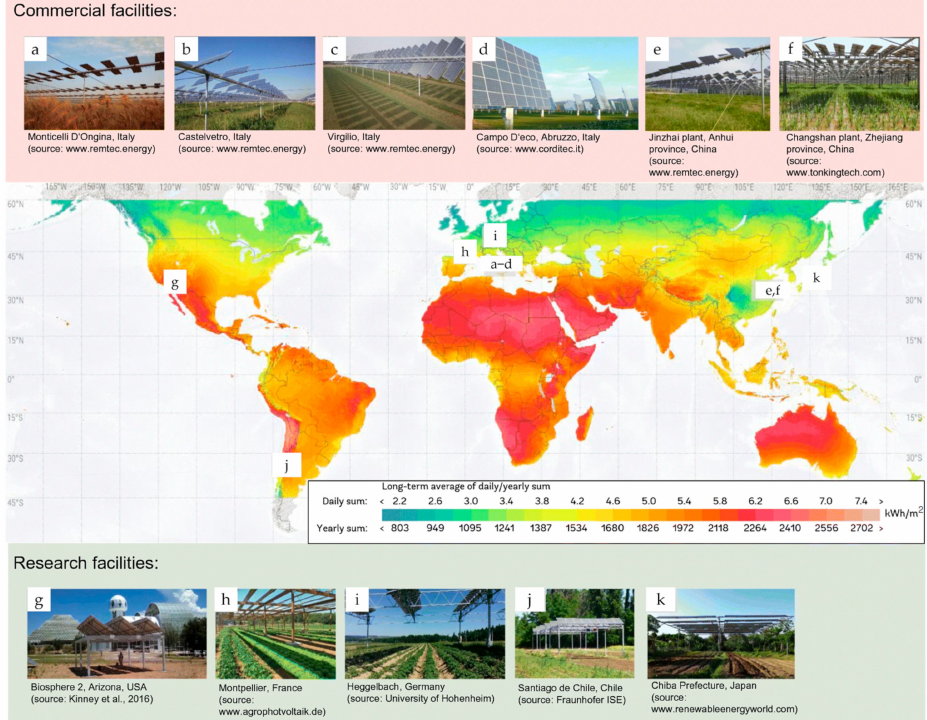
Figure 4. Geographical distribution of agrivoltaic projects for industrial and research facilities worldwide [38]. a; Monticelli D’Ongina Italy (www.remtec.energy (accessed on 22 March 2023)), b; Castelvelo Italy (www.remtec.energy (accessed on 22 March 2023)), c; Virgilio Italy (www.remtec. energy (accessed on 22 March 2023)), d; Campo D’eco Abruzzo Italy (www.corditec.it (accessed on 22 March 2023)), e; Jinzhai plant Anhui Province China (www.remtec.energy (accessed on 22 March 2023)), f; Changshan plant Zhejiang Province China (www.tonkingtech.com (accessed on 22 March 2023)), g; Biosphere 2, Arizona, USA [39], h; Montpellier France (www.agrophotvoltaik.de (accessed on 22 March 2023)), k; Chiba Prefecture Japan (www.renewableenergyworld.com (accessed on 22 March 2023)). Copyright 2019,